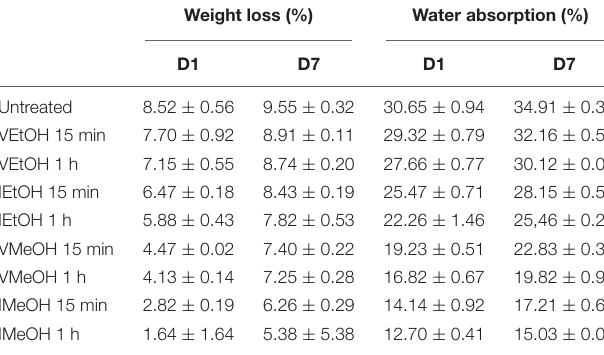
TABLE 4 | Summary of DSC data obtained from films with different post-treatments.